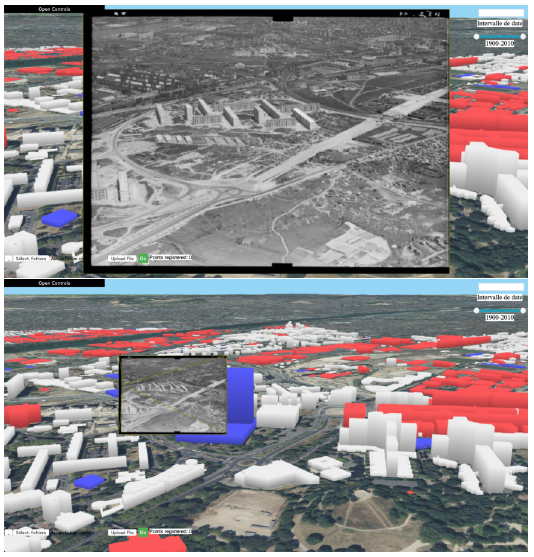
Figure 5. Navigation between points of view: oblique image seen from a camera viewpoint (top) or a free viewpoint (bottom).